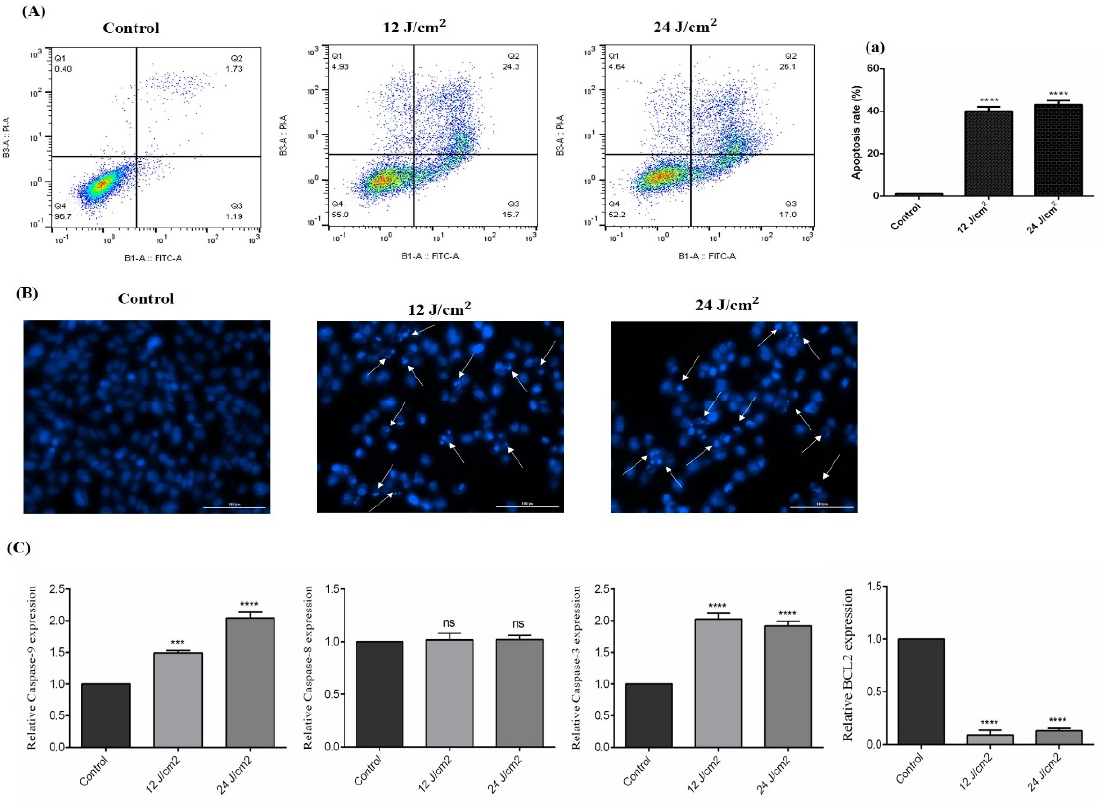
Figure 5. The percentage of apoptotic cells following ZnPc-PDT. Apoptosis was studied after ZnPc-PDT using ( A , a ) flow cytometry; ( B ) DAPI staining; ( C ) qRT-PCR. The results are expressed as mean ± SD ( n = 3); *** p < 0.001, **** p < 0.0001 versus control.